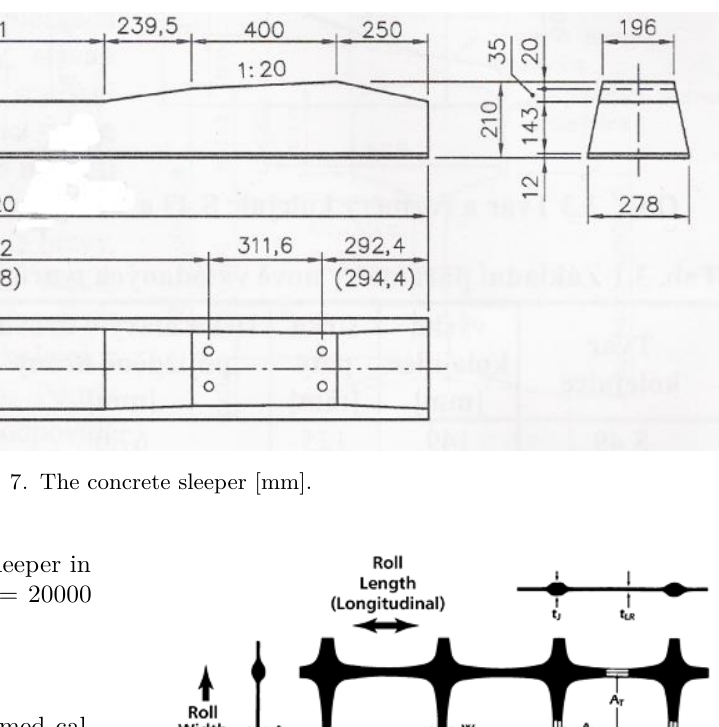
MPa, Poisson’s ratio µ = 0 , 2.